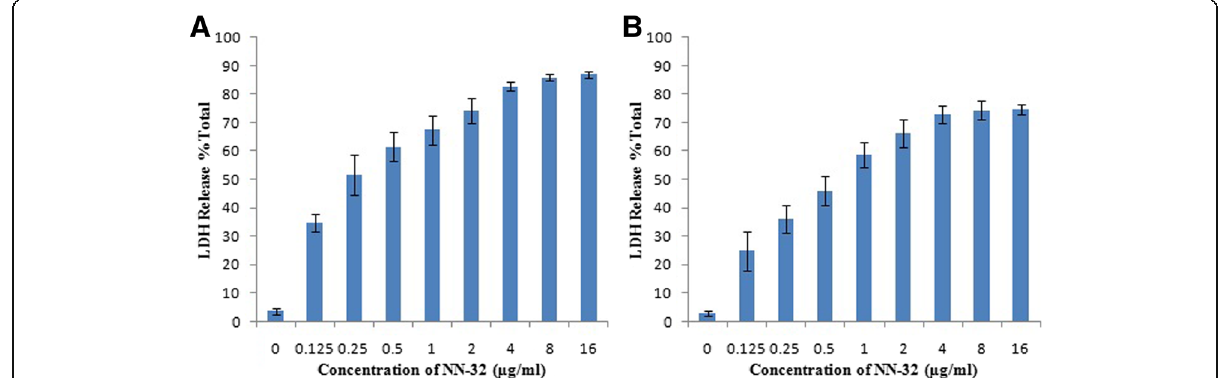
Fig. 8 Lactate Dehydrogenase (LDH) release from ( a ) MCF-7 cells and, ( b ) MDA-MB-231 cells treated with the NN-32 toxin. Values are expressed as mean ± Std. Dev ( n =